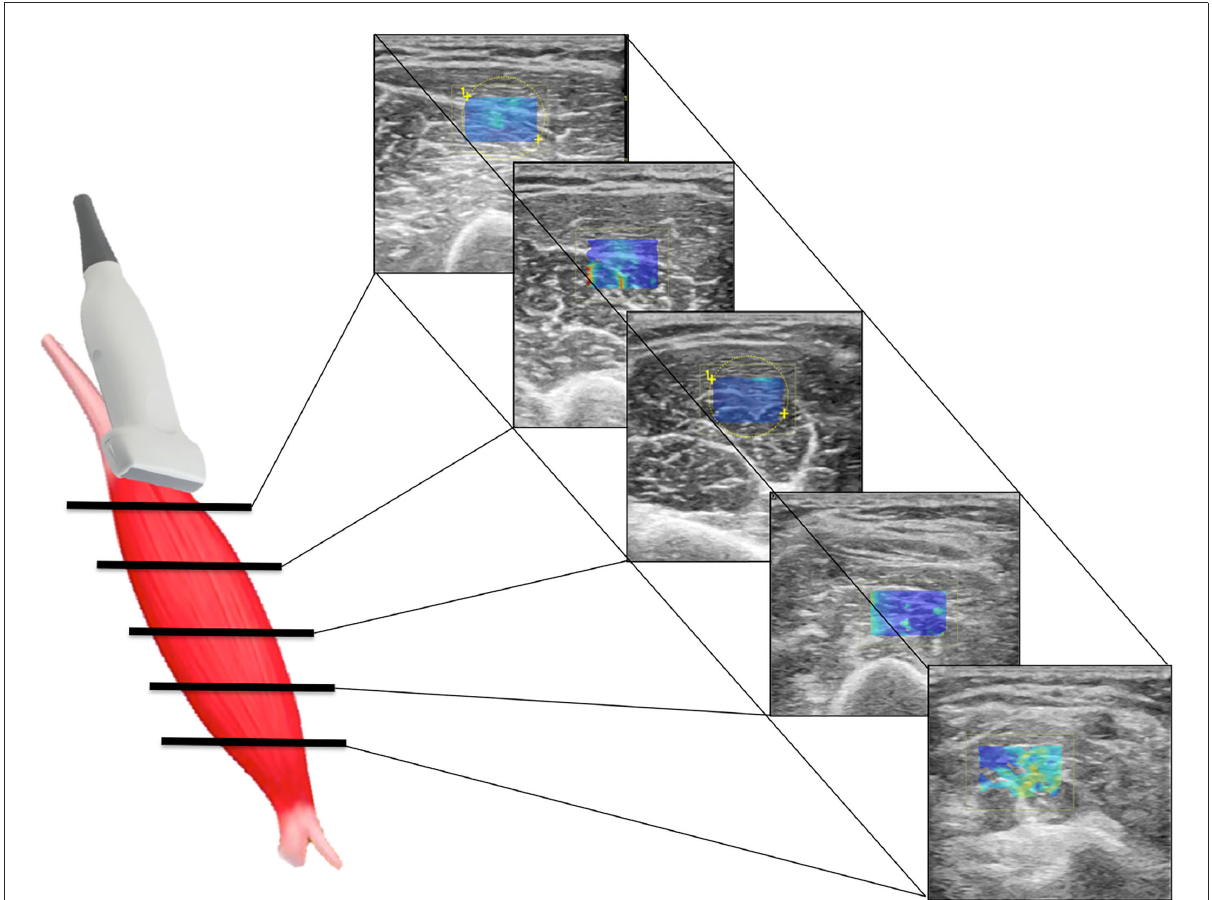
FIGURE1 Scheme illustrating SWE acquisition on the short axis of muscular fibers: the transducer is placed on the muscle belly performing consecutive axial scans to assess the maximum amount of muscle (left); in each scan, SW velocities are measured in the positioned rectangular ROI generating the relative color-coded elastogram superimposed to the B-mode image (right). The stiffness at any location within the ROI is sampled using the measurement tool (dotted circles). A final median value is then expressed.